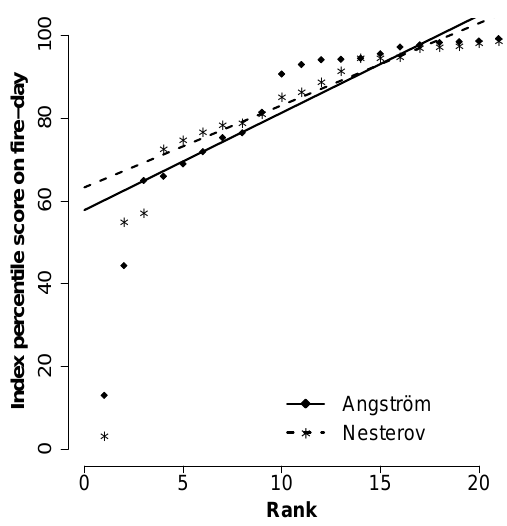
Fig. 6. Ranked percentile curve for the Angstr¨om and Nesterov indices, applied to the 21 fires that occurred in the Graz region,